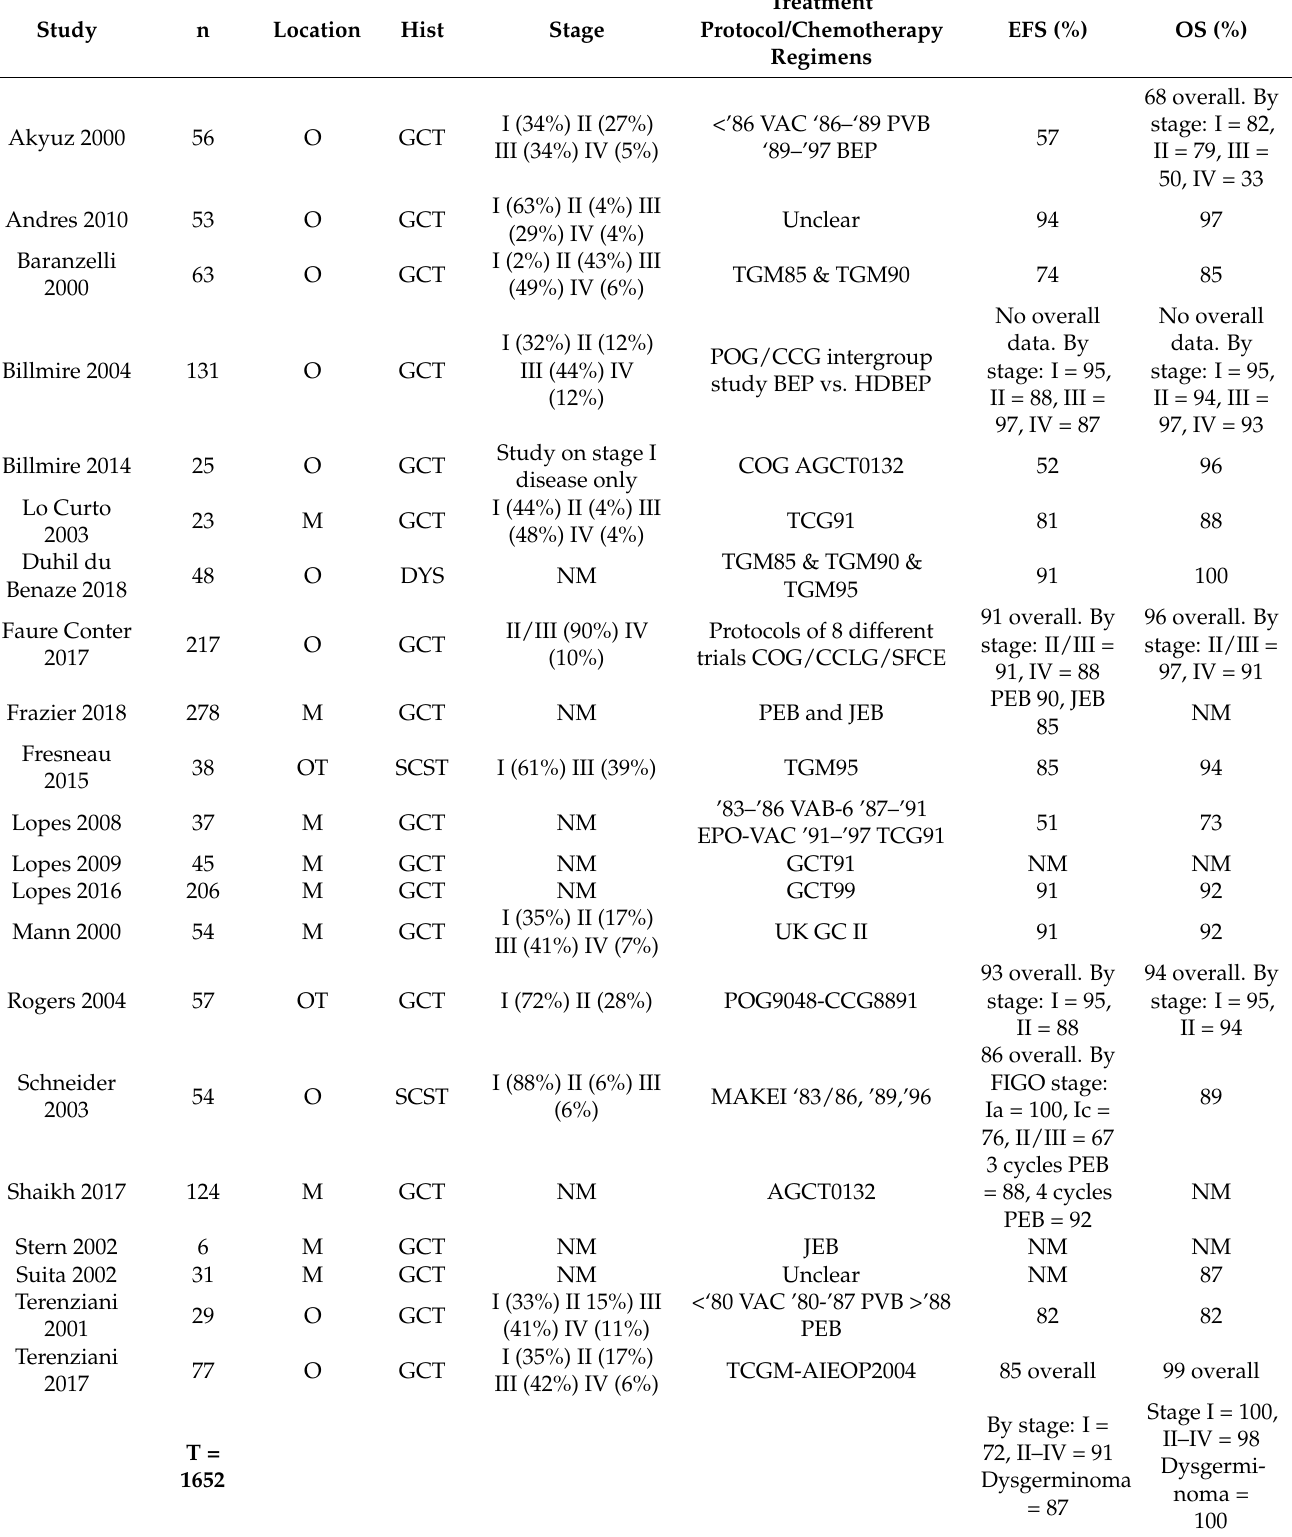
Table 1. Details on the studies of ovarian